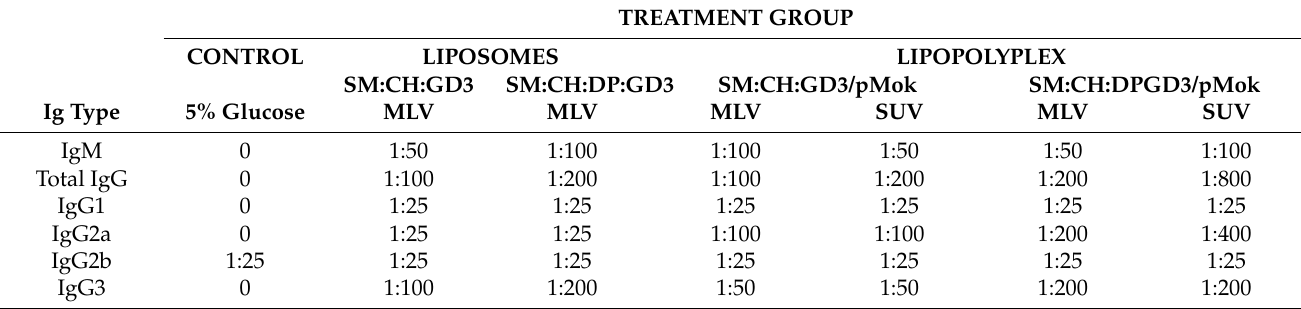
Table 4. Characterization of the specific isotypes of anti-GD3 immunoglobulins obtained after the third vaccination dose. Immunoglob- ulin titration was determined by ELISA. The titers correspond with the maximal dilution of mice serum that yielded an optical density above 0.100. These determinations were performed in triplicate and only results with dispersion lower than 5% were accepted.